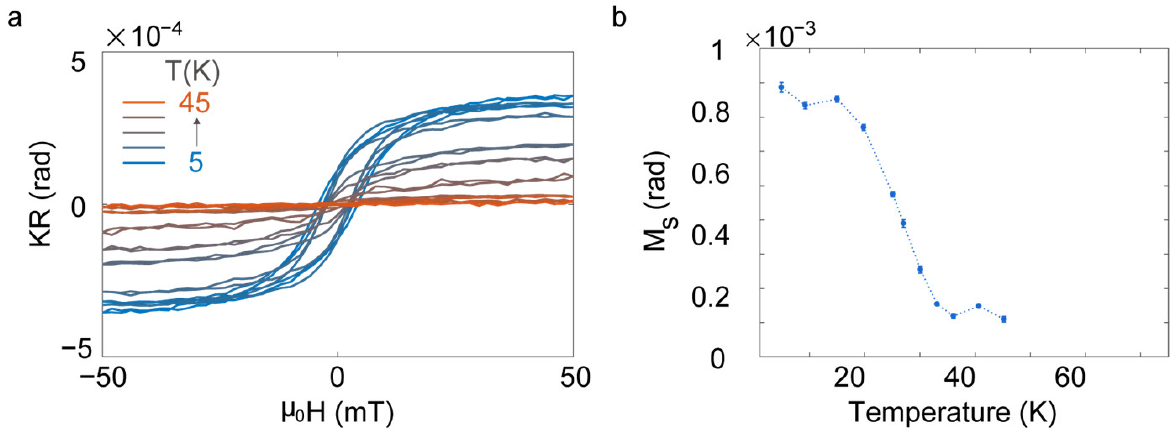
Figure 4. ( a ) Magneto-optic Kerr hysteresis loops at different temperatures, measured in a partially degraded CGT sample. ( b ) Saturated magnetization of CGT versus temperature. Error bars denote the standard deviation of saturated magnetization.